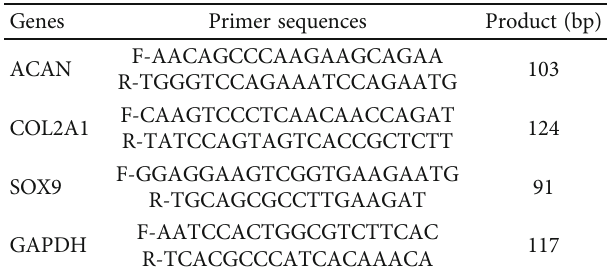
Table 1: Sequences of primers for RT-PCR